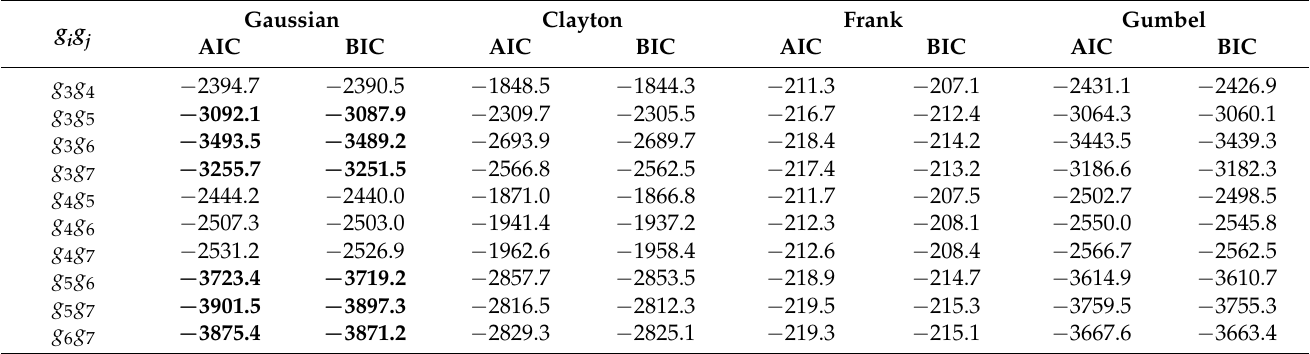
Table 6. List of calculated results of AIC and BIC values (the bolded parts in the table are the minimum values of AIC and BIC for each failure mode combination).